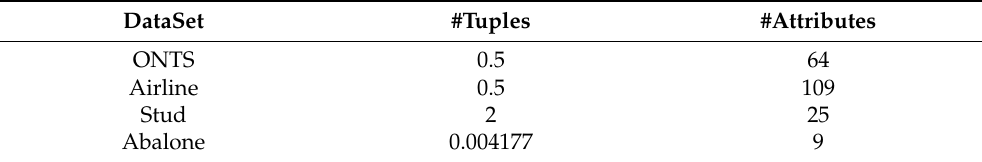
Table 1. Summary of experimental dataset.